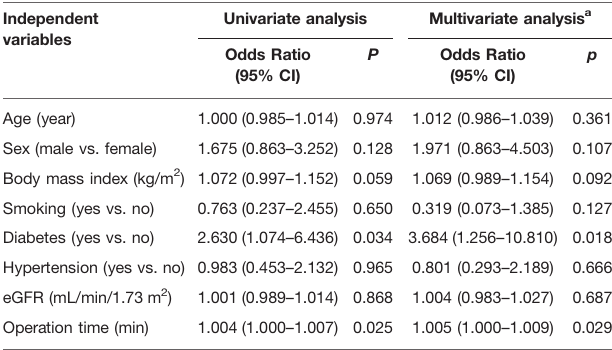
TABLE 2 | Associations between clinical factors and postoperative lipiduria (dependent